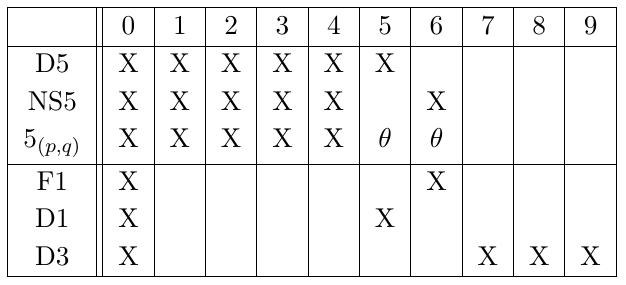
Table 1 . Brane array for 5d N = 1 theories and half-BPS loop operators. (tan (cid:18) = q